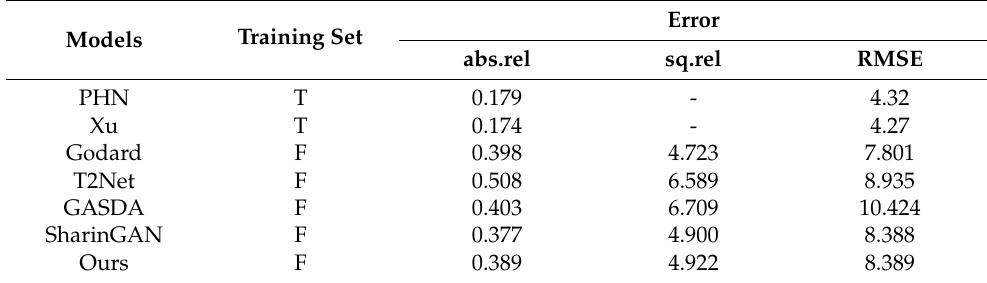
Table 3. Comparison between our method and other methods on the Make3D dataset. T means that the training set is